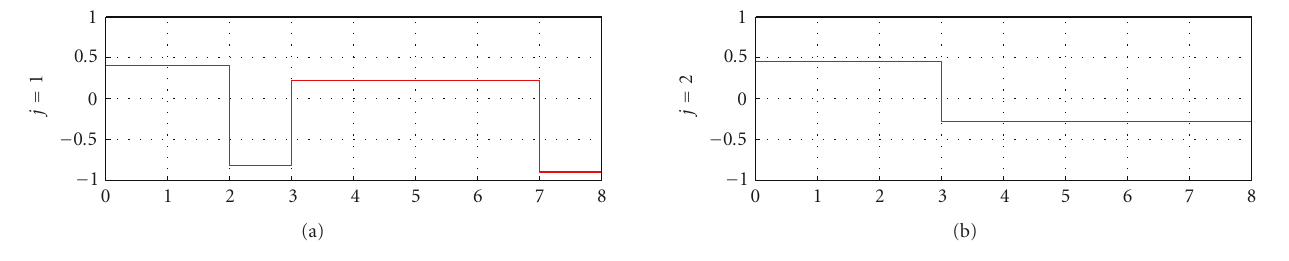
Figure 5: Haar wavelet functions at resolution levels j =